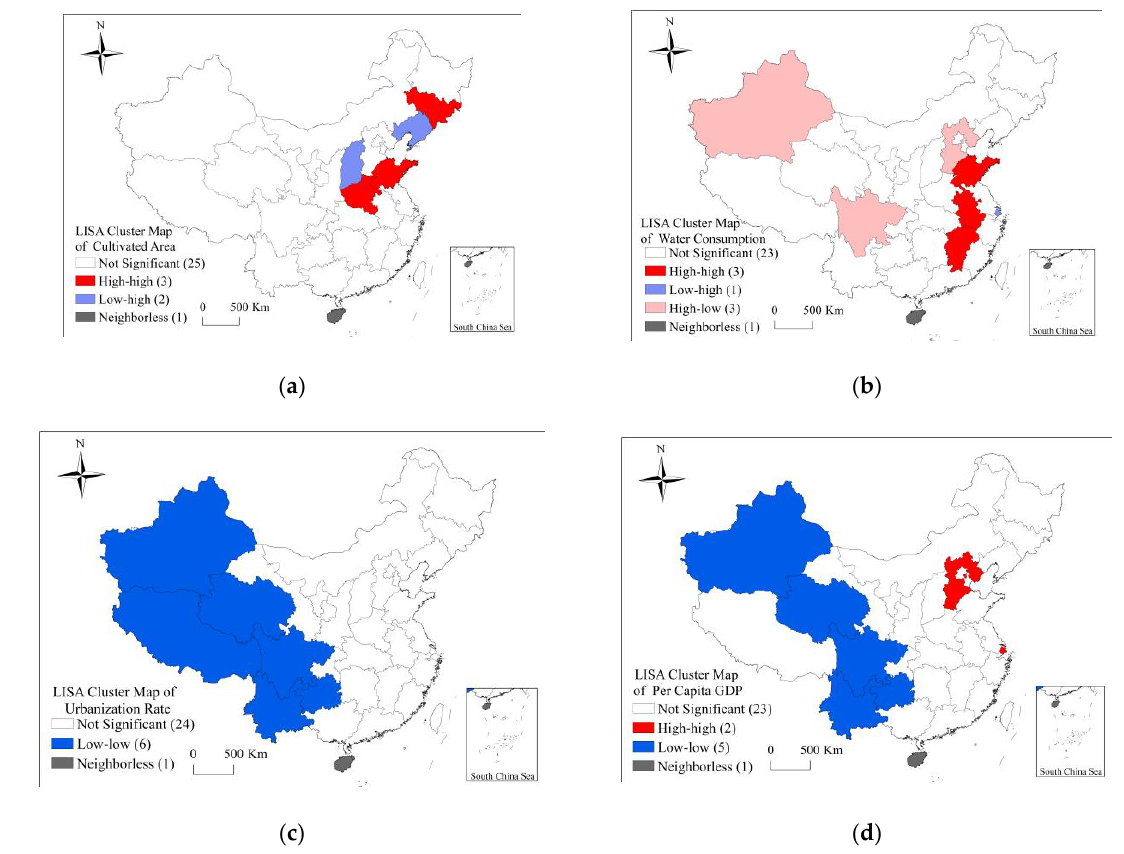
Figure 6. LISA cluster maps for anthropogenic factors: ( a ) cultivated area; ( b ) water consumption; ( c ) urbanization rate; and ( d ) per capita GDP.